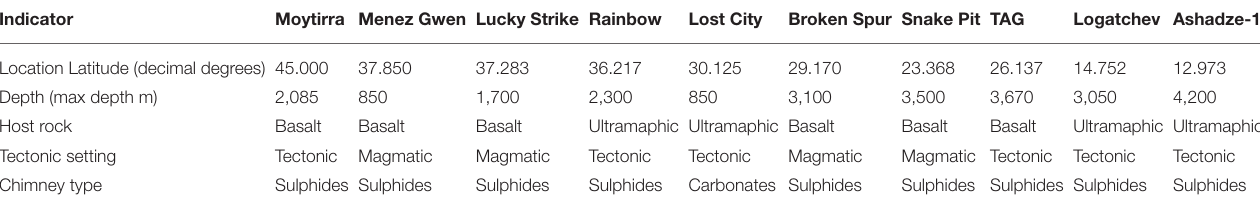
TABLE 1 | Environmental data for the 10 vent fields on the northern Mid-Atlantic Ridge.